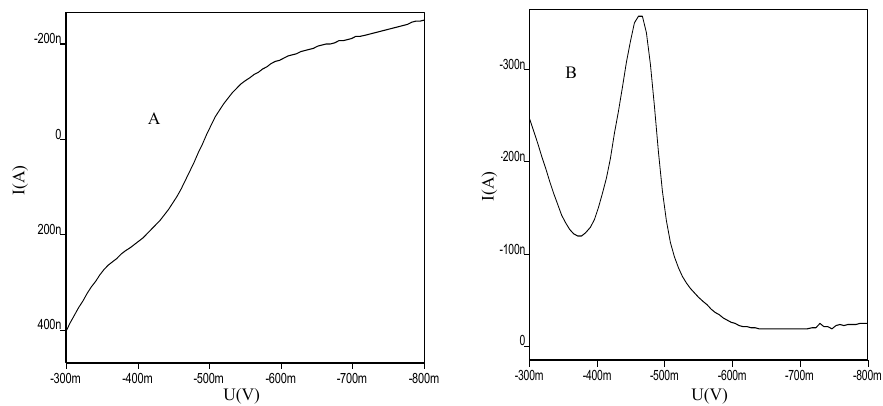
Figure 2 . (A).Direct current Polarogram of 2 µM cysteine in 0.02 M NaCl, pH 5.2±0.01, scan rate 20 mV/s. (B). Differential Pulse Polarogram of 2 µM cysteine in 0.02M NaCl, pH 5.2±0.01, scan rate 20mV/s, pulse amplitude 50 mv.